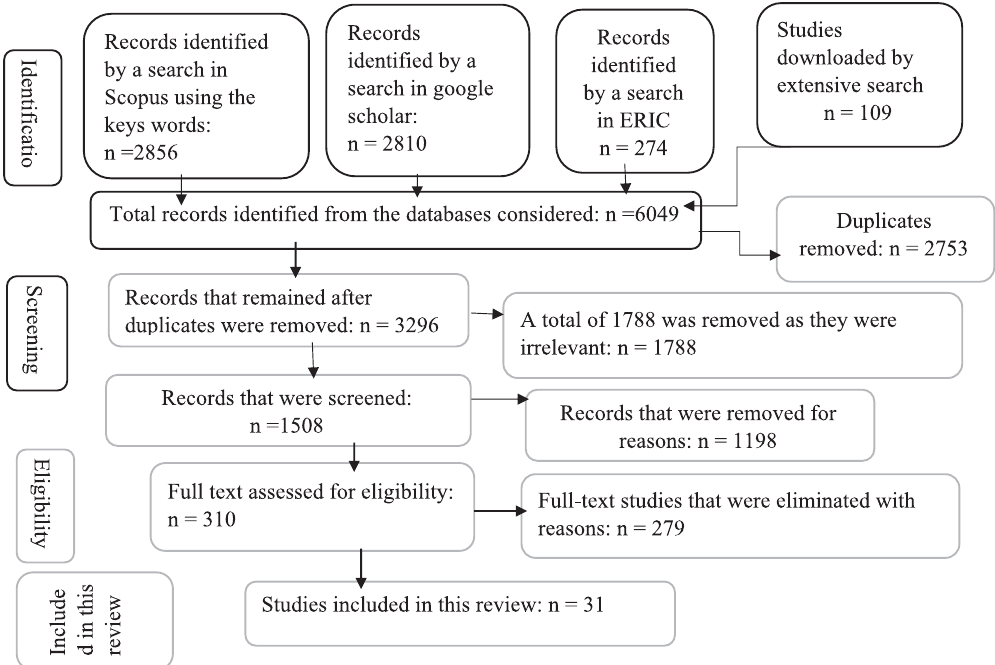
FIG. 1. Preferred reporting items for systematic reviews and meta-analysis (PRISMA; [14])